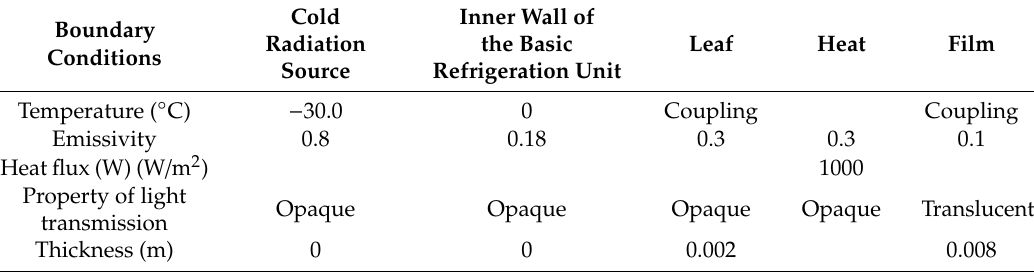
Table 1. Aspects of the boundary